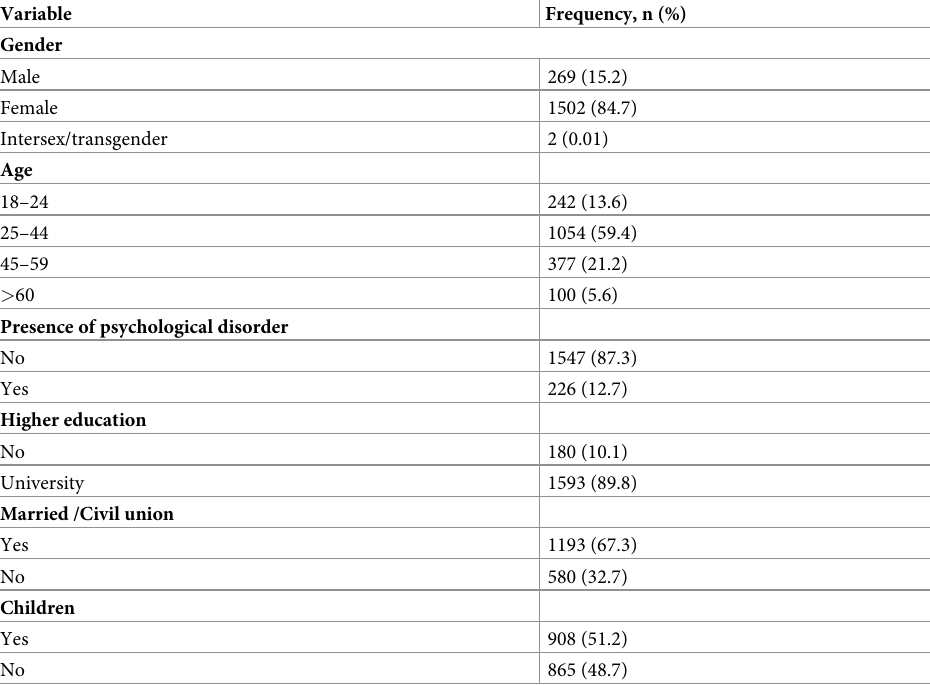
Table 1. Demographics and characteristics of the